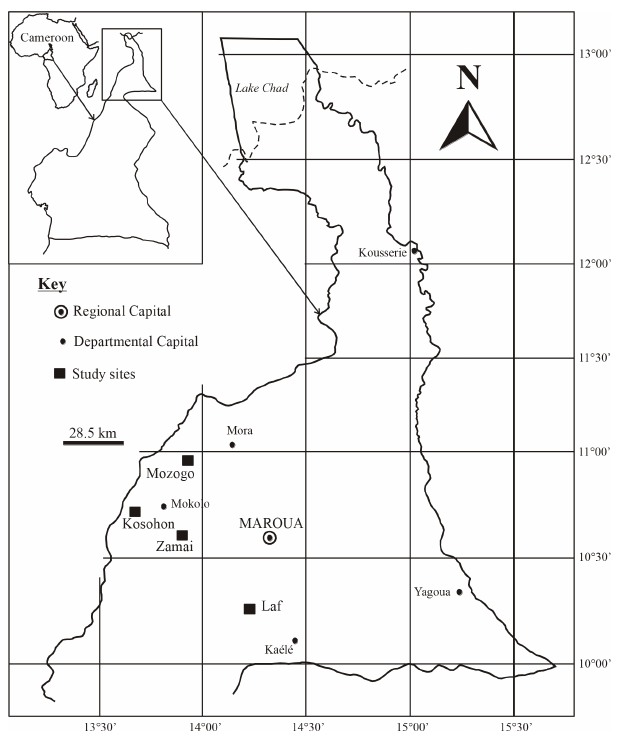
Figure 1. Locations of the study